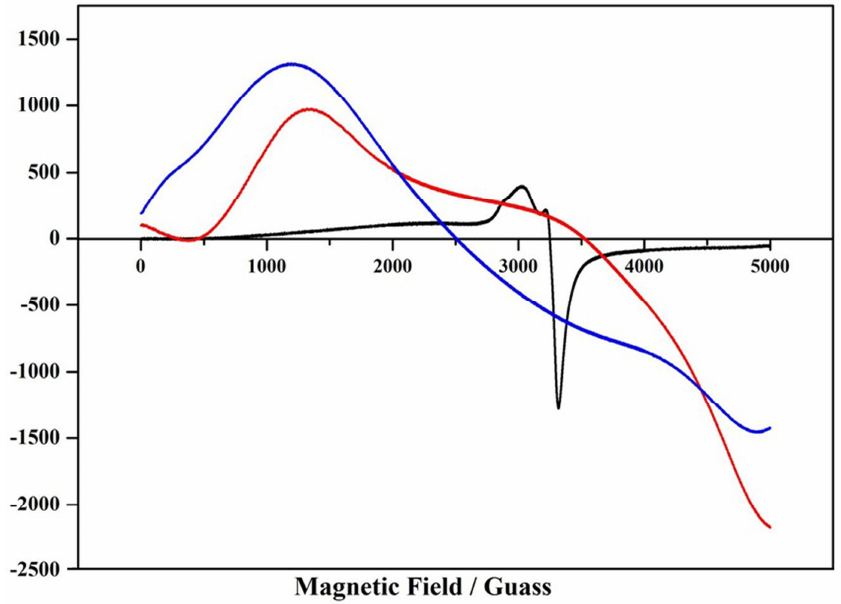
Fig. 2. EPR spectra of blue line) Fe